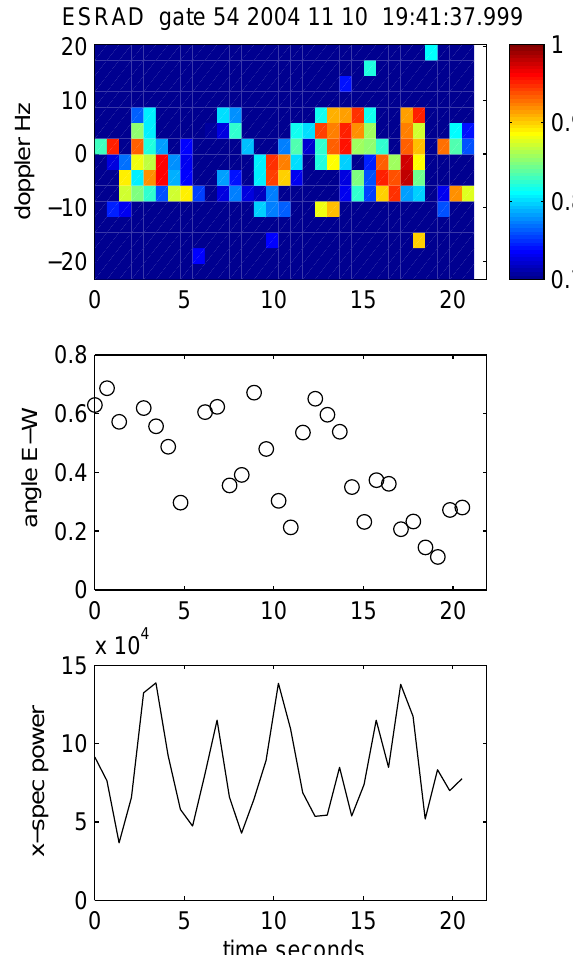
Fig. 15. ESRAD observations for the 20-s interval 19:41:15– 19:41:38 at the base of the PMWE layer. Upper panel shows cross spectral coherence for the signals from an East-West antenna- segment pair. Middle panel shows the east-west angle of arrival for the signal at maximum coherence (coherence > 0.9). Third panel shows the spectral power at zero